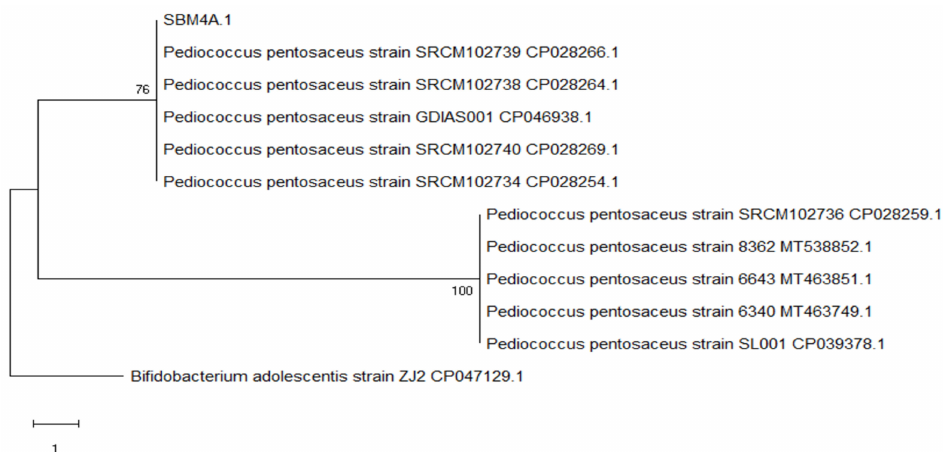
Figure 6. Evolutionary relationships of isolate SBM4A regarding bacterial strains in Genebank NCBI by using the maximum parsimony method with a bootstrap value of 100 ×